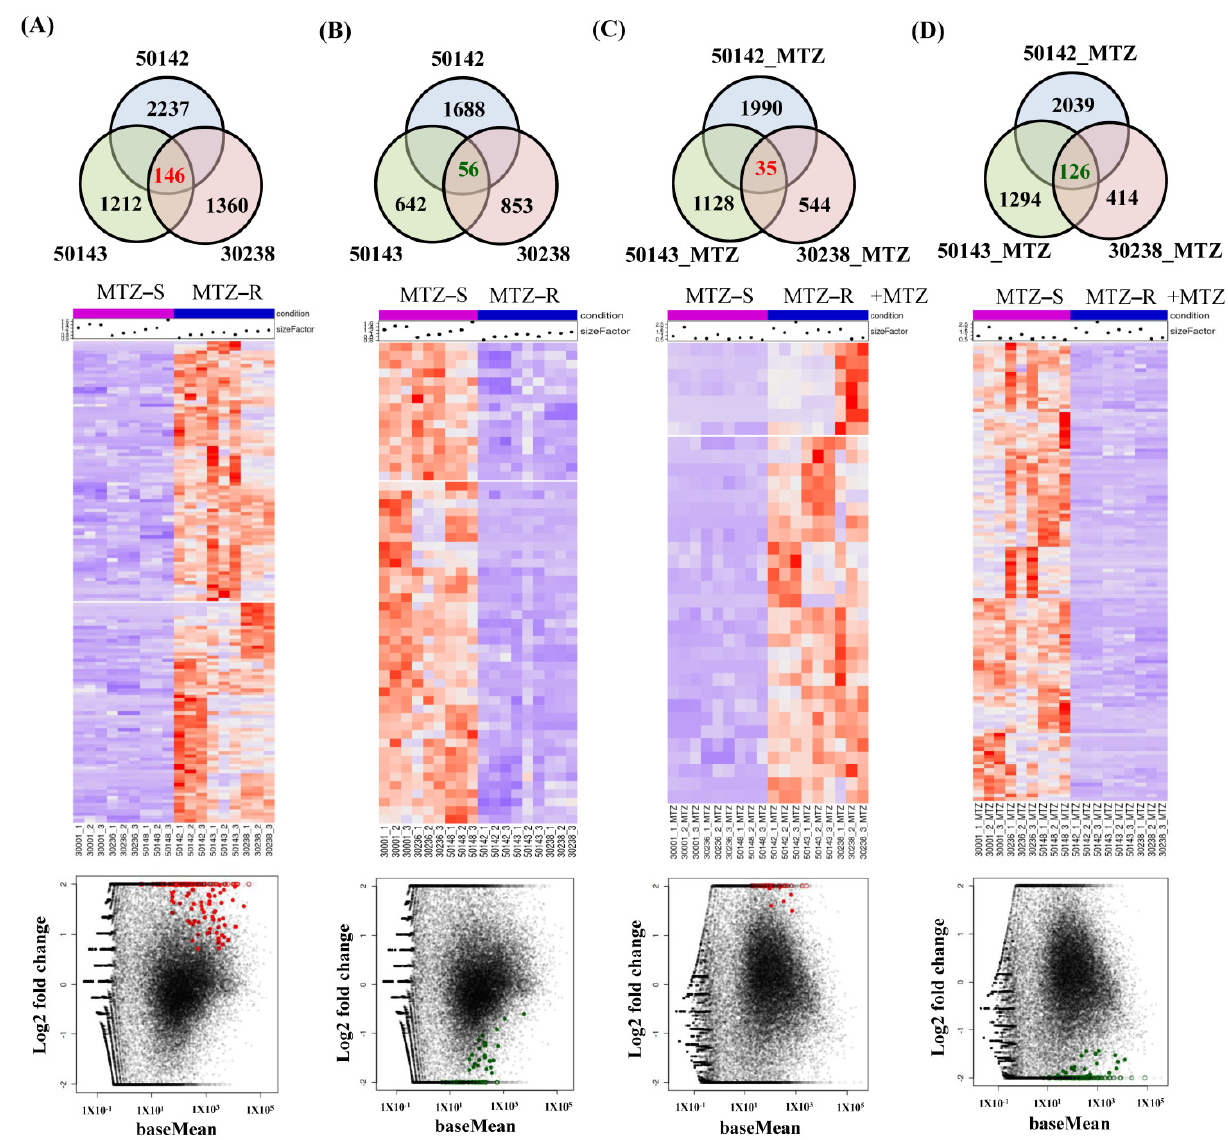
Figure 4. Identification of common DEGs in all MTZ-R T. vaginalis strains compared with the MTZ-S group treated with or without MTZ. Venn diagram showing the number of genes shared by three MTZ-R T. vaginalis strains (Tv_50142, Tv50143, and Tv30238) whose expression is upregulated ( A ) and downregulated ( B ) in comparison with three MTZ-S strains (Tv-30001, Tv-30236, and Tv50148). Upon MTZ treatment, the number of upregulated ( C ) and downregulated ( D ) genes among the identical MTZ-R strains in comparison with the MTZ-S strains were also analyzed. The gene expression patterns of DEGs in all MTZ-R strains compared with those of MTZ-S in the presence or absence of MTZ were analyzed by cluster analysis and shown as heatmaps. Genes shown in red and purple color indicate upregulation and downregulation, respectively. MA plots represent the expression levels (baseMean) and expression changes (log2 fold change in normalized counts values) in the corresponding DEGs. Table 1. Shared DEGs in all MTZ-R transcriptomes compared with those of MTZ-S.